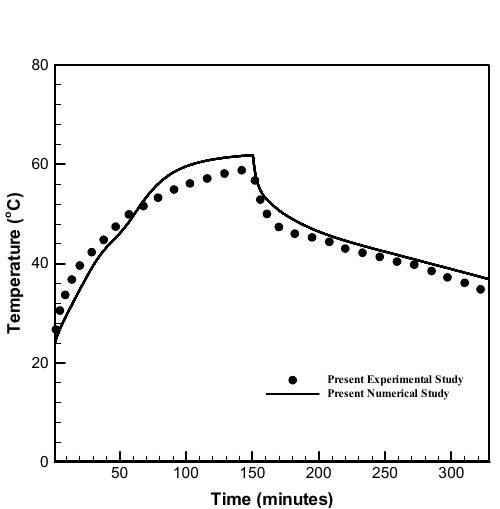
Figure 3. Schematic diagram of experimental setup.